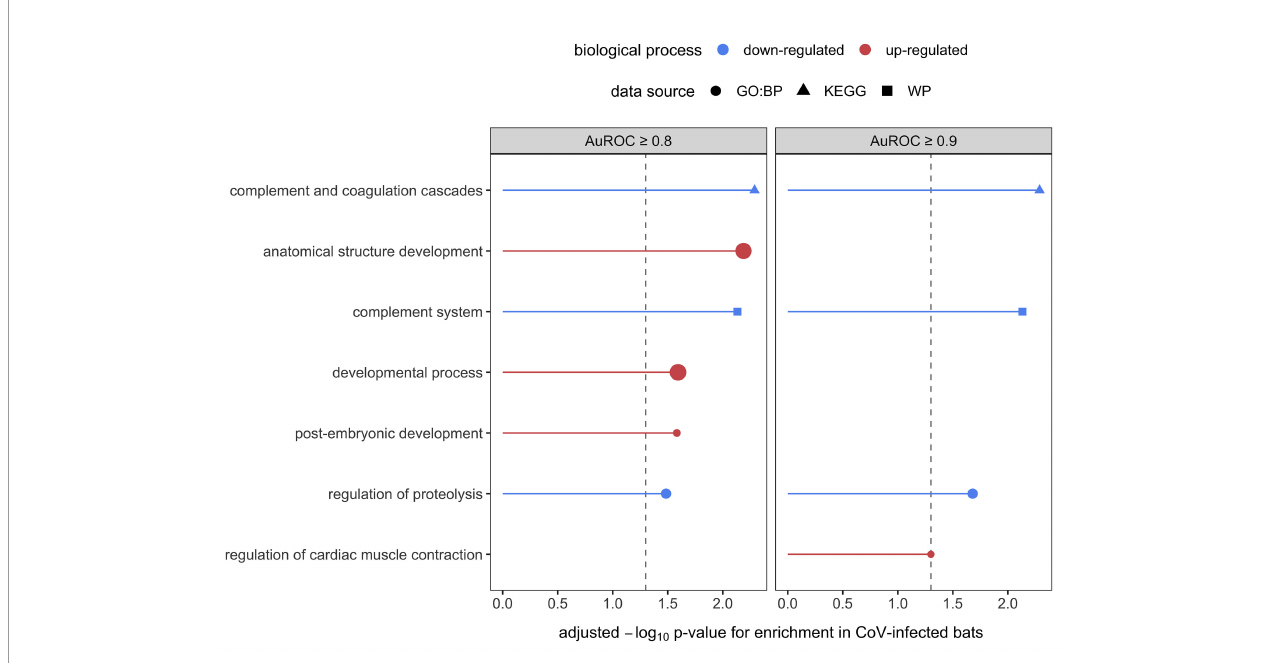
FIGURE 4 | Enrichment analyses of the 32 candidate biomarkers of CoV infection, strati fi ed by less-conservative (AuROC ≥ 0.8) and strict (AuROC ≥ 0.9) classi fi ers. Biological processes with signi fi cant enrichment in CoV-infected bats after SCS correction are displayed, with up- and downregulated processes shown in red and blue, respectively. Processes are labeled by